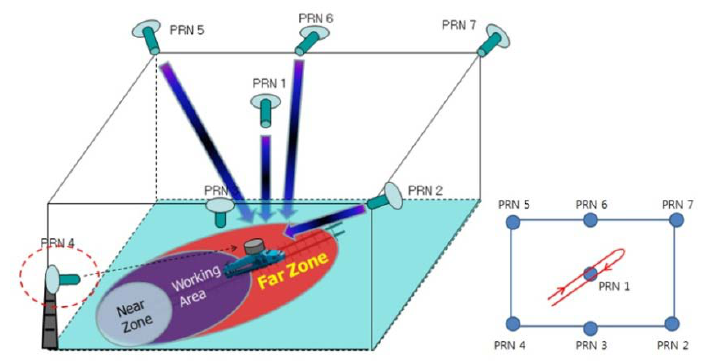
Figure 15. Test 1: Test setup and user